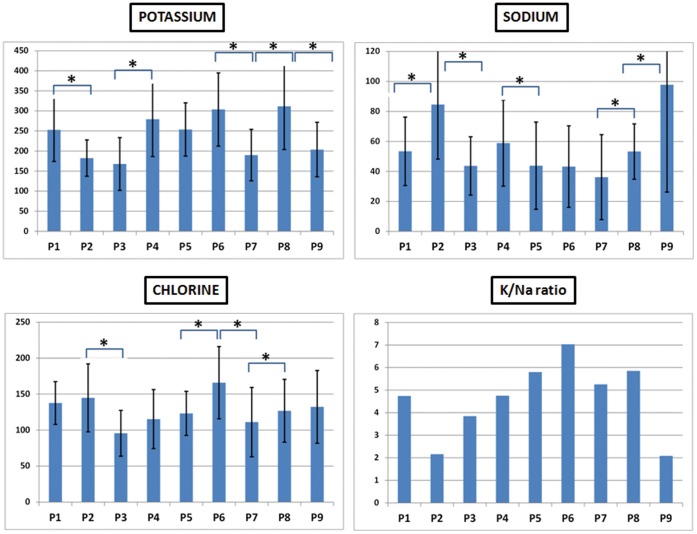
Intracellular ionic concentrations of potassium, sodium, chlorine and K/Na ratio of 9 consecutive cell passages of TMJF cells.Statistically significant differences between two consecutive cell passages are labeled with asterisks. All values are expressed as millimoles of each element per kilogram of cell dry weight and are shown as mean ± standard deviation.